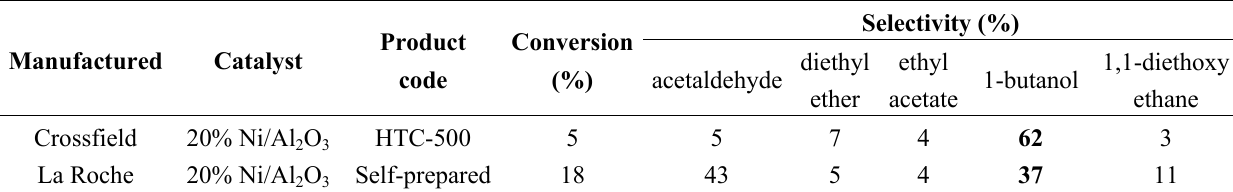
O catalyst. Based on the results 2 3